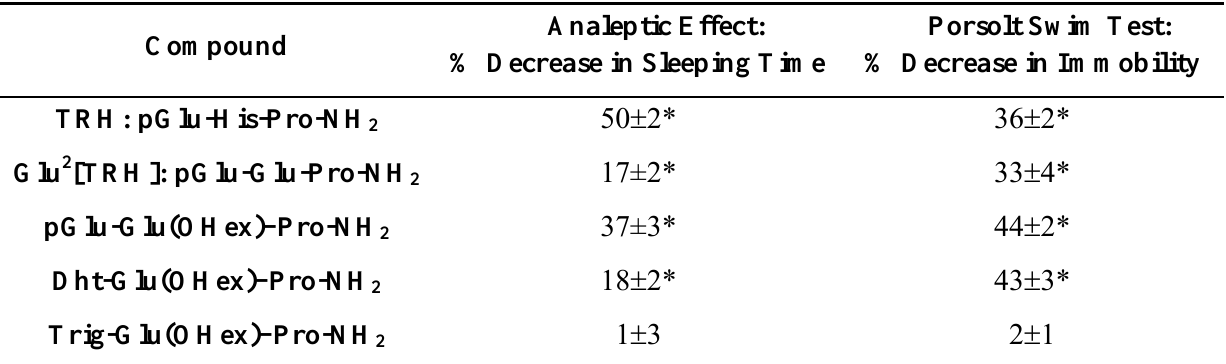
Table 4 . Comparison of analeptic (equimolar dose of 10 μ mol/kg body weight, i.v.) and antidepressant (equimolar dose of 3 of μ mol/kg body weight, i.v) effects of test